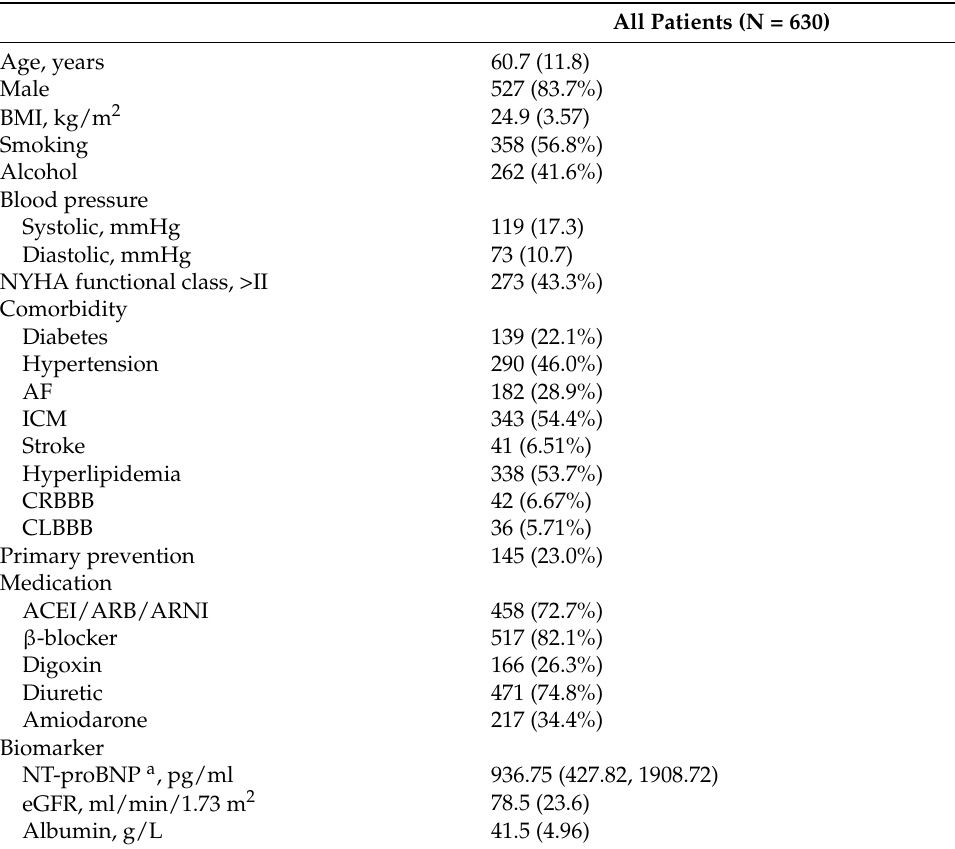
Table 1. Baseline characteristics of the study population, analyzed separately according to the LVEF and LVDD